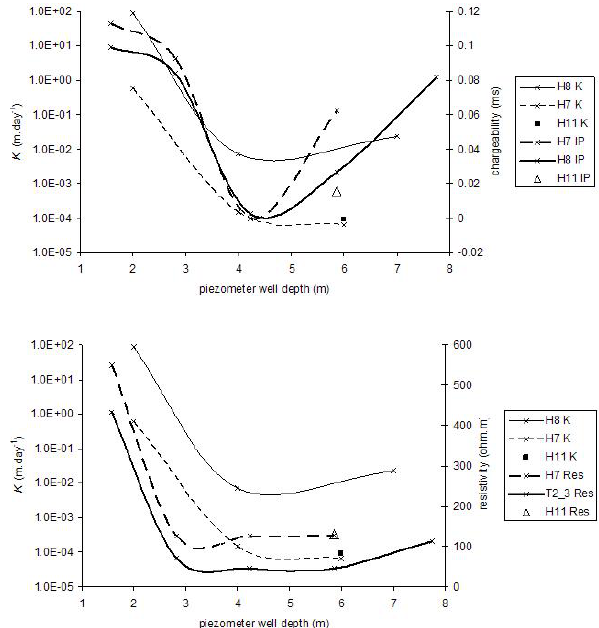
Fig. 16. Plots of log- K vs. IP measurements (above) and resistivity measurements